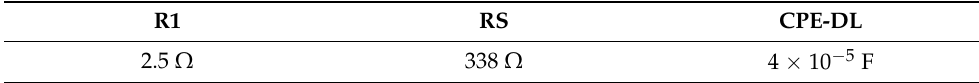
Table 1. Shows the different circuit element values for CSs@Se composite before